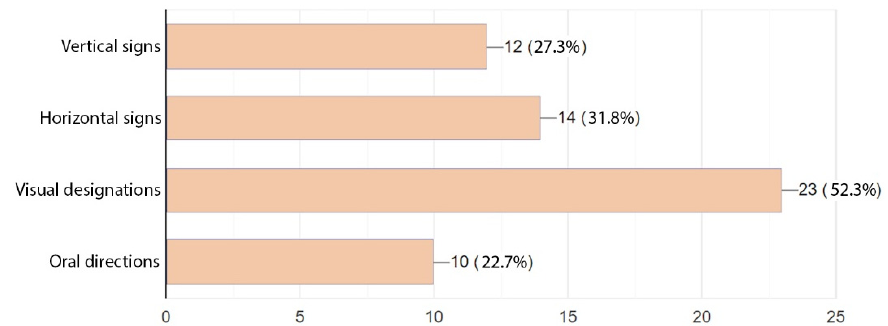
Figure 17. Preferences as to the visual identification system in a hospital—staff .